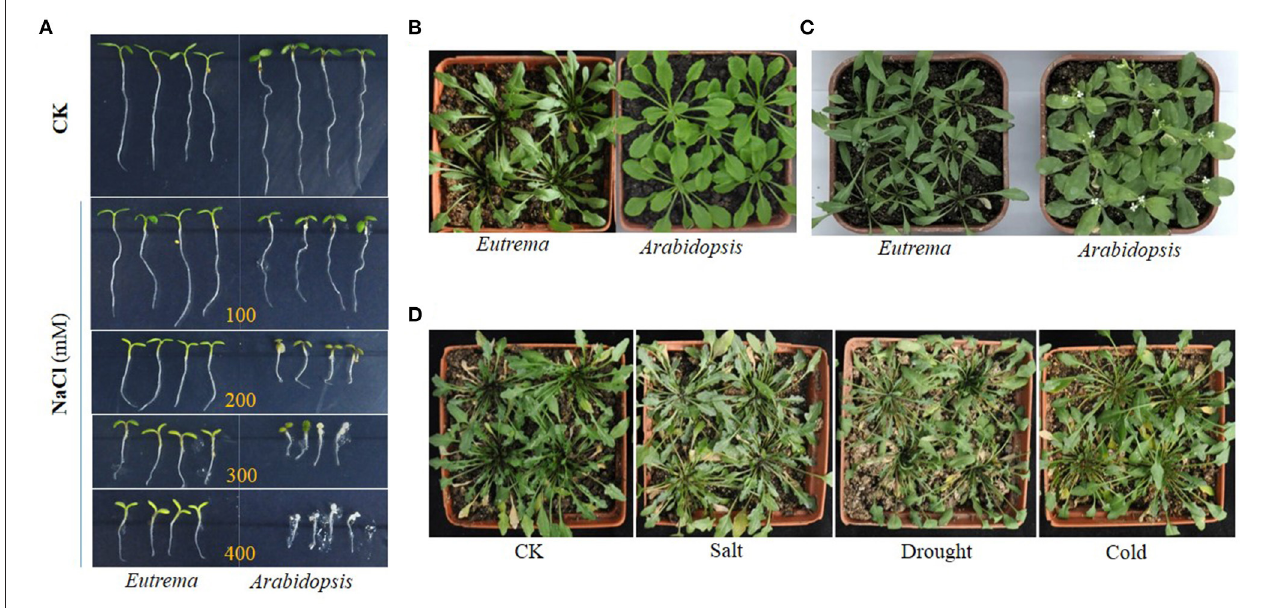
FIGURE 1 | Growth comparison of Eutrema salsugineum (Shandong) and Arabidopsis thaliana plants in the control (CK) and stress treatment conditions. (A) Growth comparison of Eutrema and Arabidopsis plants in the control and NaCl treatment (100, 200, 300, and 400mM NaCl) conditions. Eutrema seeds germinated 10 days, and Arabidopsis seeds germinated for 7 days in 1/2MS medium, then the seedlings of uniform growth moved to 1/2MS medium containing 0 (CK), 100, 200, 300, and 400mM NaCl for growing for about 5 days. (B) Growth comparison of the 50-day-old Eutrema and 30-day-old Arabidopsis plants that grow in a mixture of vermiculite, perlite and peat moss (1:1:1), with a photoperiod of 16h light/22 ◦ C and 8h dark/18 ◦ C. (C) Growth comparison of the 60-day-old Eutrema and 40-day-old Arabidopsis plants. The surface sterilized Eutrema seeds planted in 1/2MS medium, was firstly stratified treatment (4 ◦ C for 13 days) to synchronize the germination, then moved into the growth chamber for 7 days; the seedlings were transplanted in nutrient soil for 34 days, followed by 6 day-salt treatment using 200mM NaCl. The surface sterilized Arabidopsis seeds planted in 1/2MS medium, was firstly stratified treatment in 4 ◦ C for 3 days, then moved into a growth chamber for 7 days; the seedlings were transplanted in nutrient soil containing vermiculite, perlite, and peat moss (1:1:1) for 24 days, followed by 6-day salt treatment using 200mM NaCl. (D) Phenotype comparison of Eutrema plants under salt, drought, and cold stresses. Eutrema seeds were planted in a mixture of vermiculite, perlite, and peat moss (1:1:1) in a greenhouse for 60 days with a photoperiod of 16h light/22 ◦ C and 8h dark/18 ◦ C, followed by stress treatments using 300mM NaCl (Salt), no watering (Drought) and low temperature of 4–6 ◦ C (Cold) for 2 weeks, respectively, or kept in normal growth condition